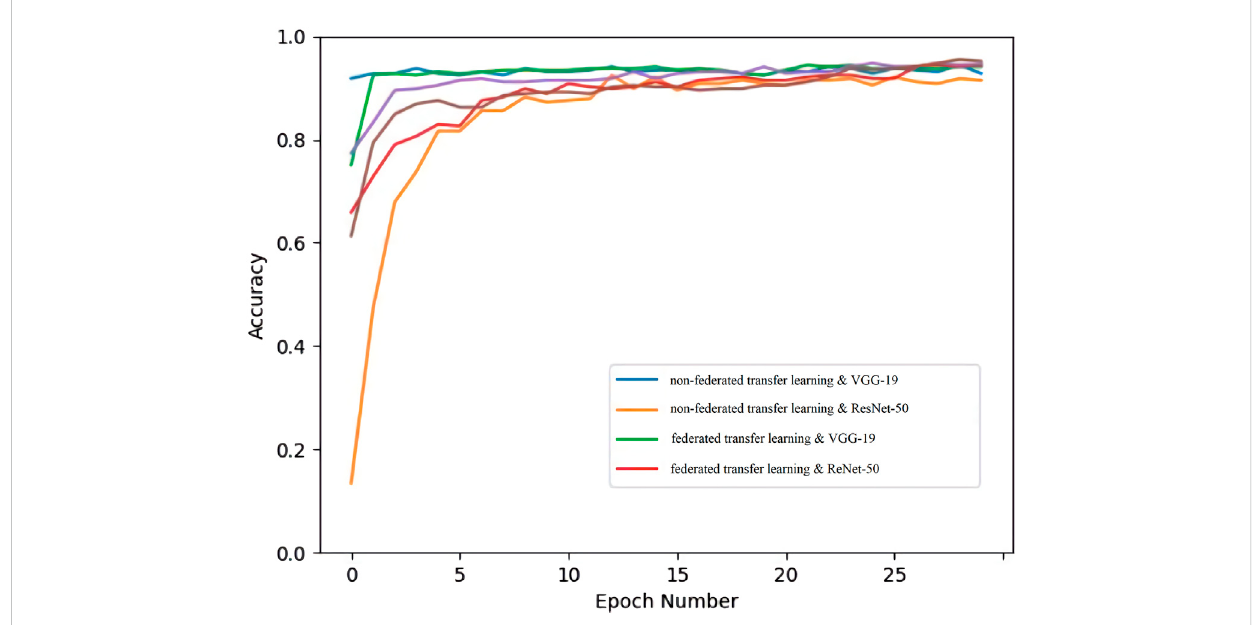
FIGURE 7 Comparison of convergence speed between different